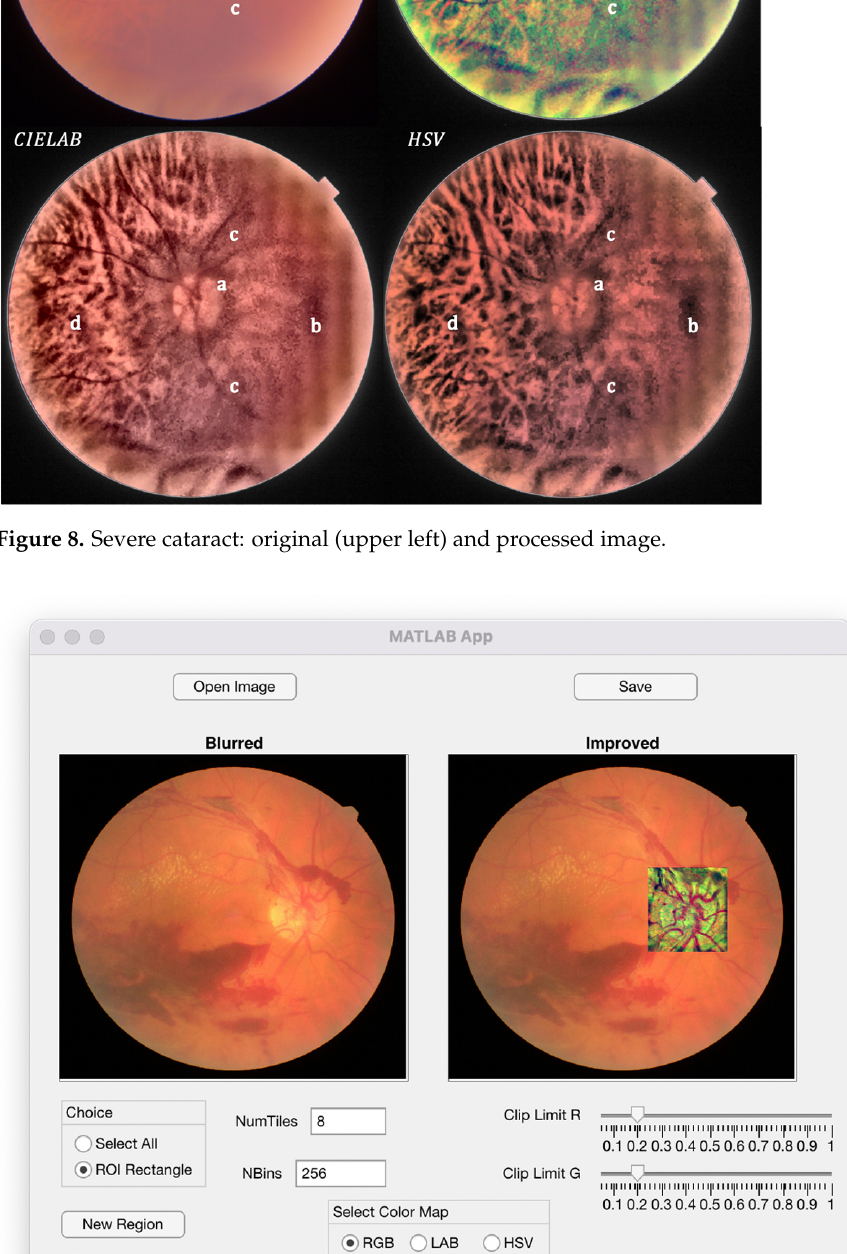
Figure 8. Severe cataract: original (upper left) and processed image.